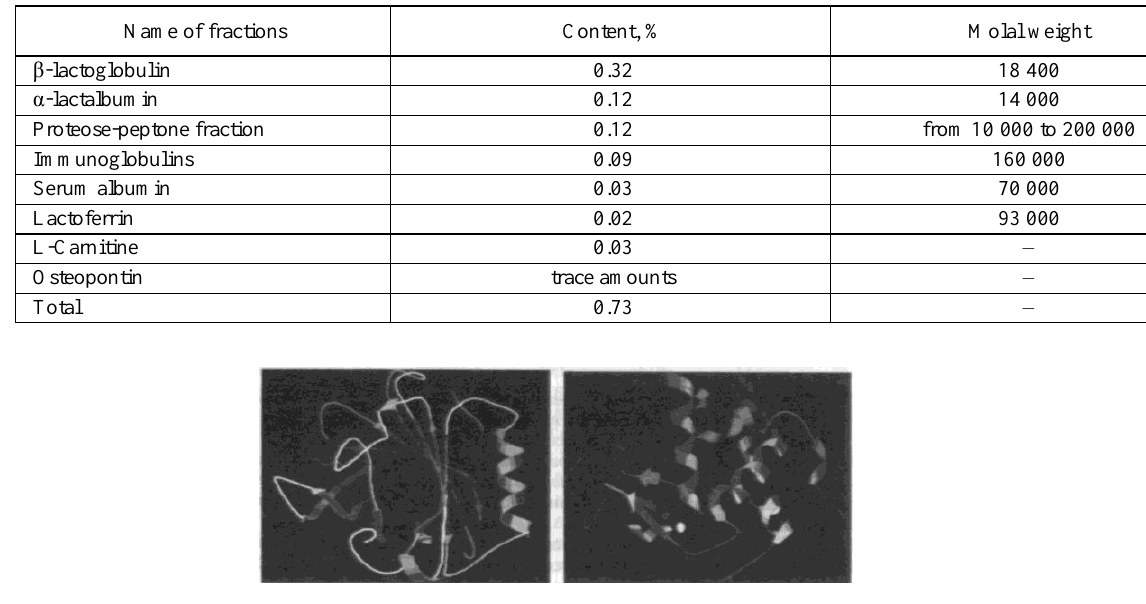
Fig. 4. Сhromatogram of whey proteins. Table 4. Characteristic of milk serum proteins